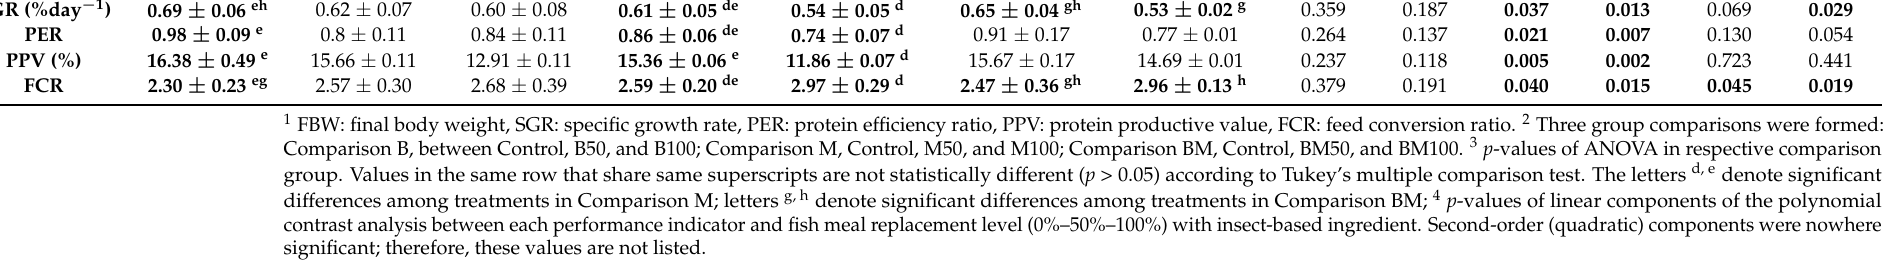
Table 6. Biometric index of African catfish (n = 18/diet group), (mean ±